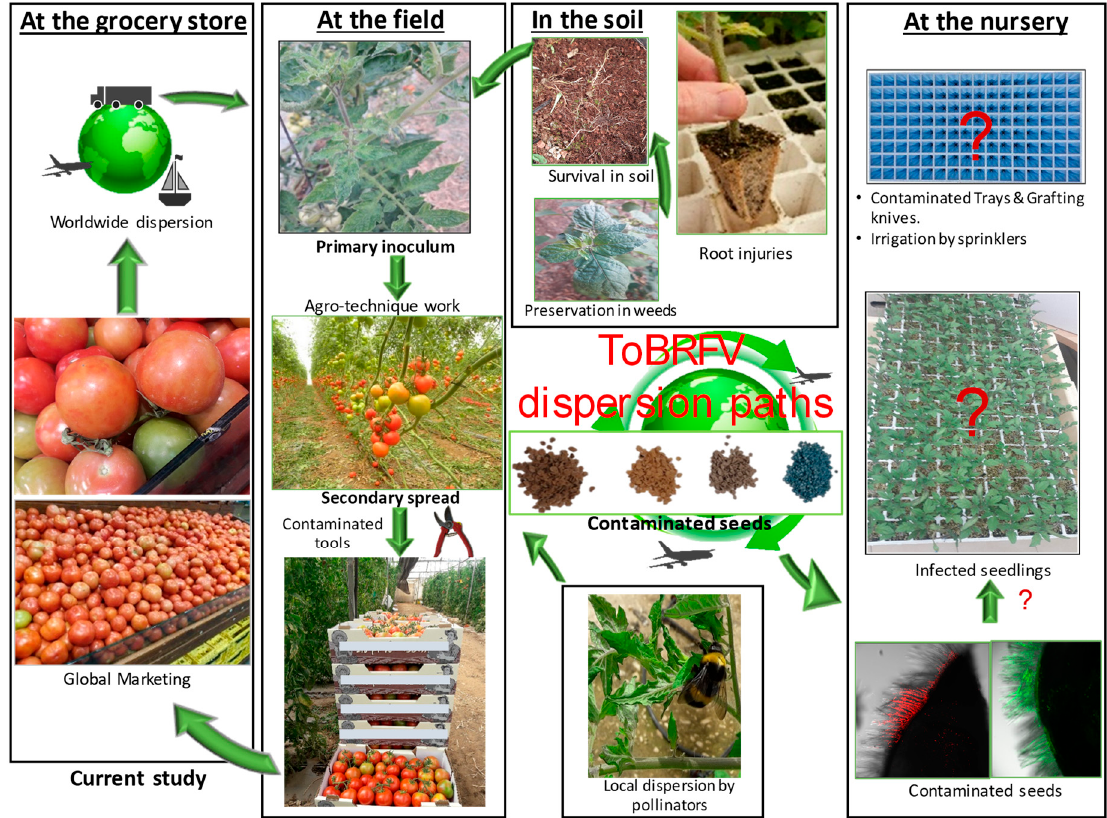
Figure 5. A general scheme illustrating the contribution of the current study to viral disease spread amid the broad epidemiological context of factors involved in tomato brown rugose fruit virus (ToBRFV) disease distribution.